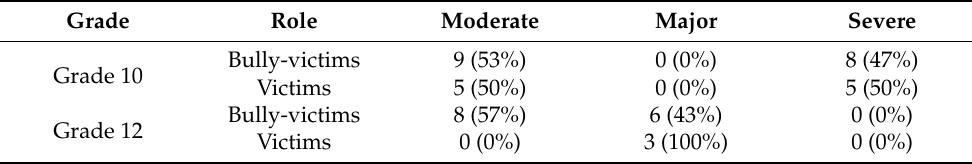
Table 6. Cyberbullying